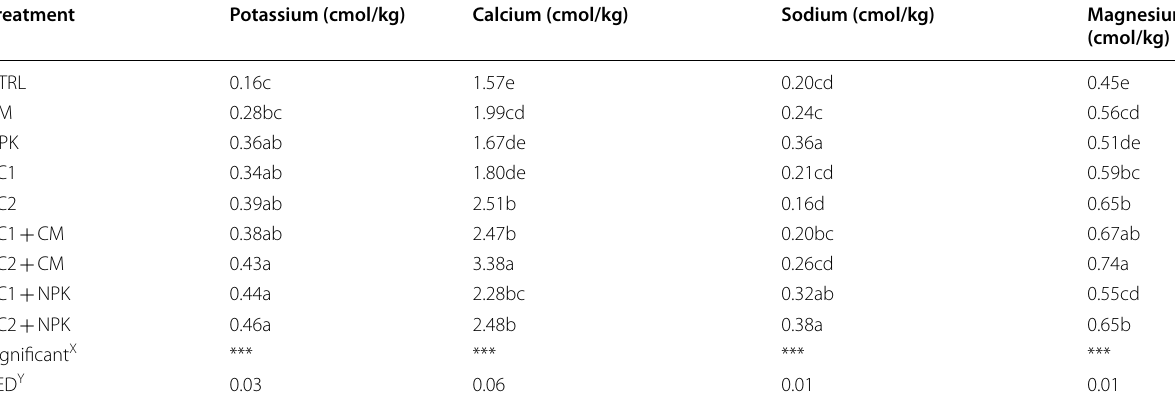
Table 5 Residual effects of biochar farmyard, compost and/or NPK applications on the exchangeable bases (K + , Mg 2 + Ca 2 + Na + )